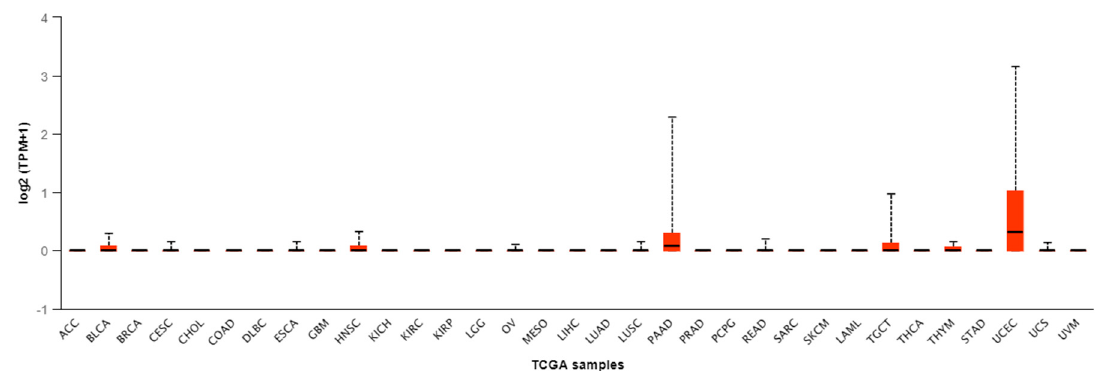
Figure 1. Expression level of CGB1 in cancer, according to The Cancer Genome Atlas (TCGA) data;